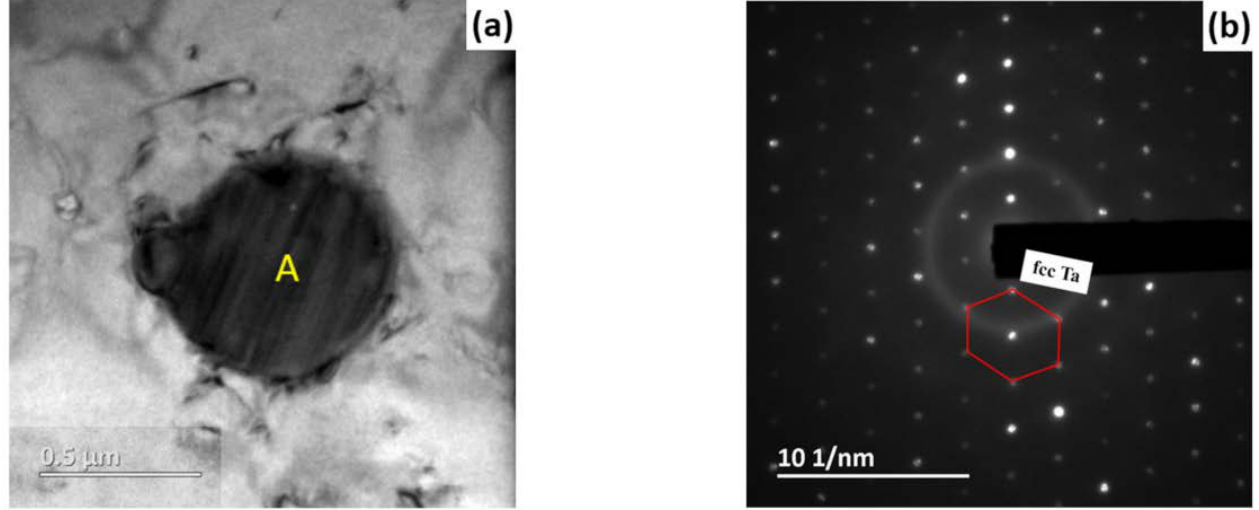
Figure 21. TEM micrographs of an annealed specimen. ( a ) Low-magnification dark-field image; ( b ) SAED pattern of precipitate “A” in [111]